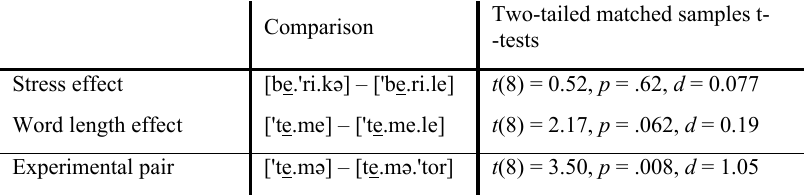
Table 1. Statistical results for the matched-samples t-tests conducted on averaged-across- -repetitions F2-F1 values at mid-point. The vowel tested is underlined. Effect size (Cohen’s d ) was calculated on the basis of standard deviation values for the groups (Dunlop, Cortina, Vaslow, & Burke, 1996). For the experimental pair, the comparison is between